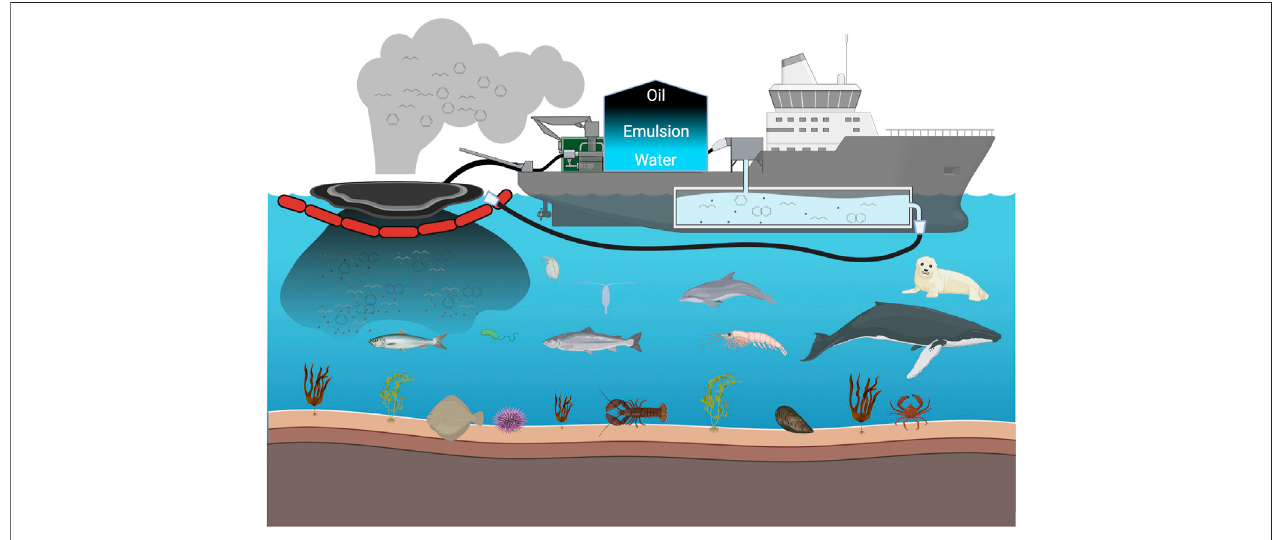
FIGURE 1 | On-sea Oil